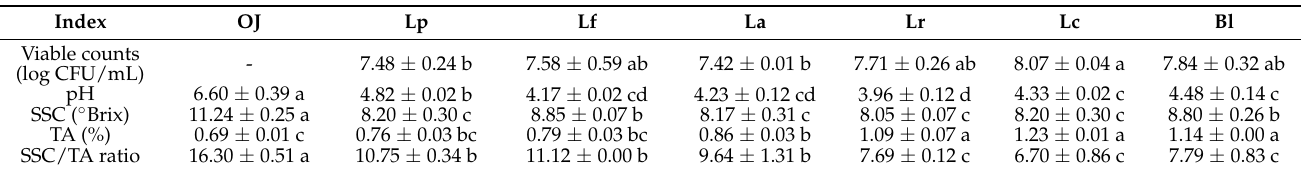
Table 1. Physicochemical characteristics and viable counts in the fermented orange juices and control ( n =